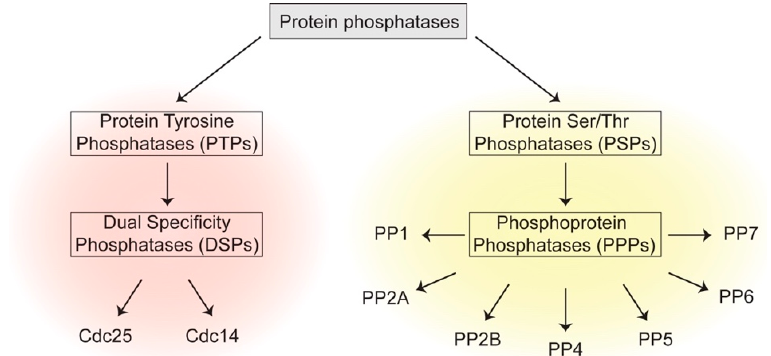
Figure 1. Protein phosphatases involved in mitosis. Protein phosphatases can be divided into two superfamilies: Protein Tyrosine Phosphatases (PTPs) and Protein Ser / Thr Phosphatases (PSPs). Although these families contain a vast array of phosphatases, those pertinent to mitosis and discussed herein are shown.